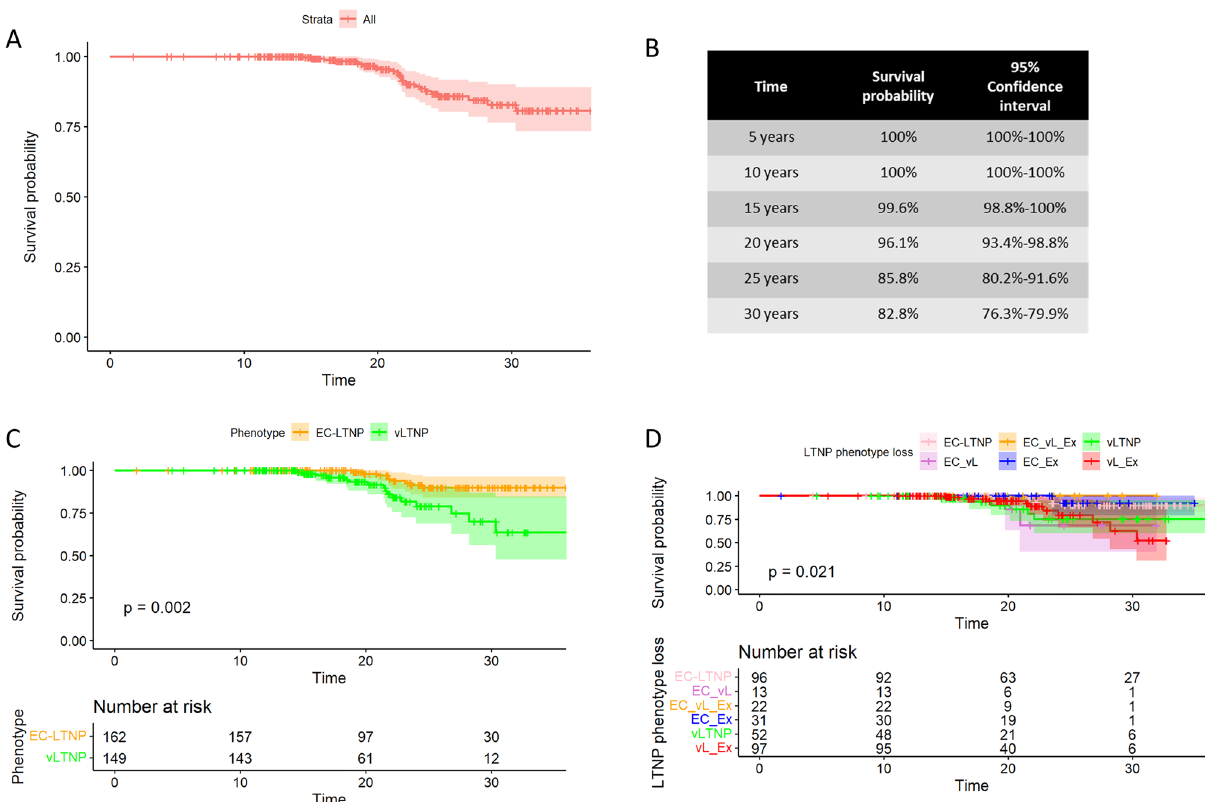
Figure 4. Probability to survive in LTNP-RIS cohort and hazard ratios. Kaplan–Meier estimates for the entire cohort ( A ) and associated survival probabilities ( B ). Kaplan–Meier estimates comparing EC-LTNP and vLTNP populations ( C ). Kaplan–Meier estimates comparing the different types of LTNP phenotype loss ( D ). Time is expressed in Kaplan-Meir curves as years from HIV +